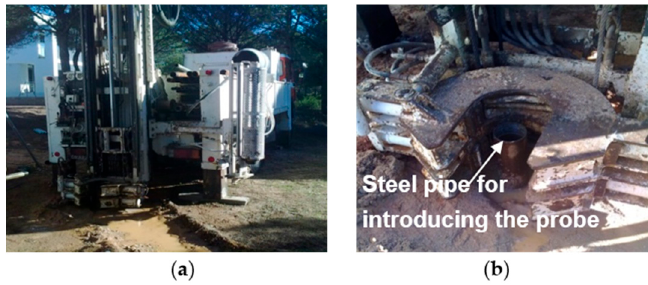
Figure 9. ( a ) Drilling machine; ( b ) Steel pipe for introducing the probe.